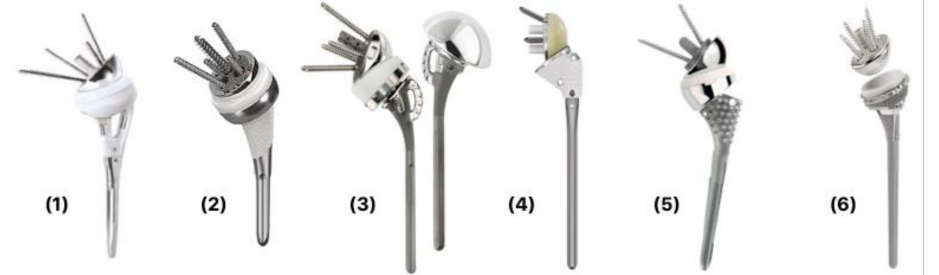
Figure 1. Six commercially available reverse fracture prosthesis designs: ( 1 ) Aequalis Reversed FX Tonier ; ( 2 ) ReUnion Stryker ; ( 3 ) Equinoxe Fracture Exactech ; ( 4 ) Affinis Fracture Mathys ; ( 5 ) Reverse Anatomical Shoulder Fracture system Zimmer ; ( 6 ) Global Unite Reverse Fracture Depuy-Synthes